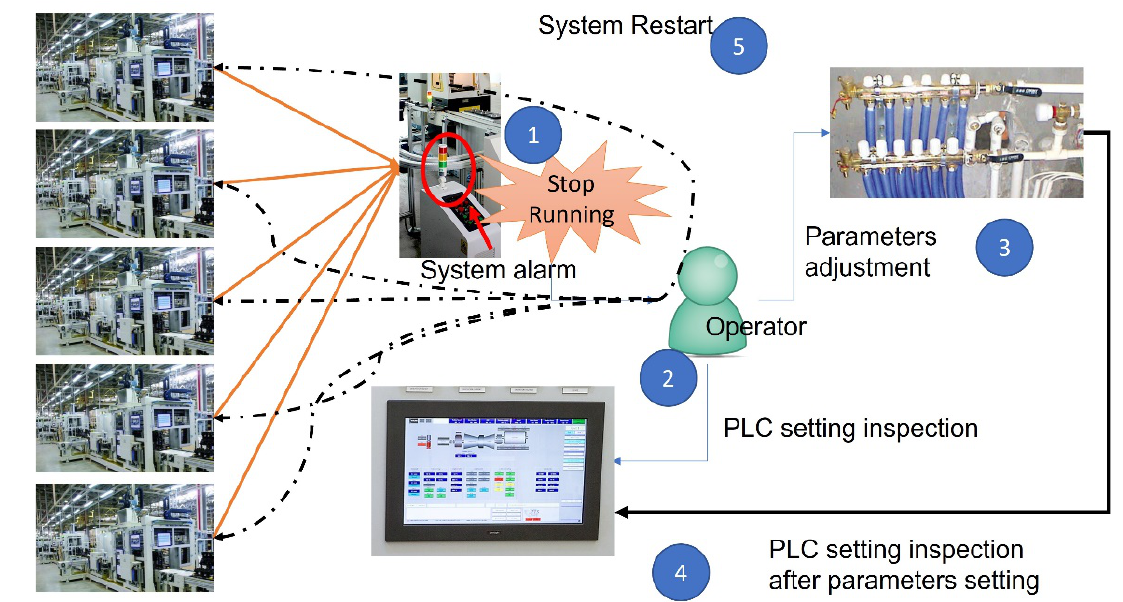
Figure 5. The conventional working process of condition monitoring by the operator.